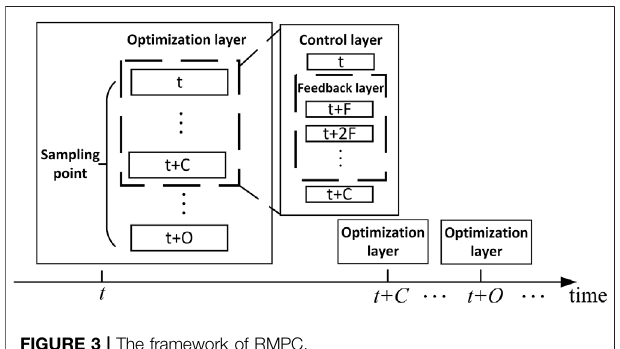
FIGURE 3 | The framework of